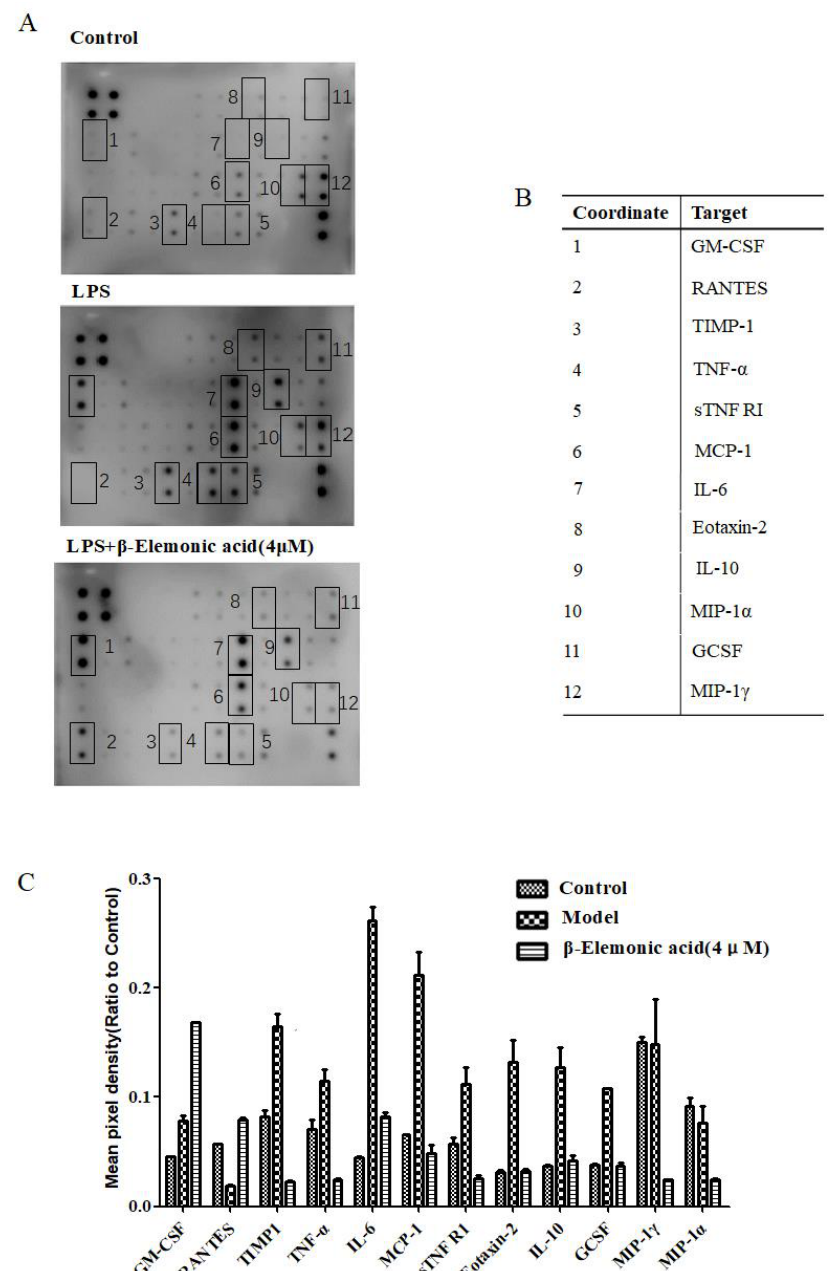
Figure 3. The effect of LPS treatment on the expression of inflammatory cytokines by RAW264.7 cells using antibody array membrane. ( A ) RAW264.7 cells were cultured in DMEM and divided into three treatment groups: control, LPS and LPS+ β -EA (4 µ M). After 24 h of incubation, the cell supernatant were collected and incubated with the antibody array membrane. ( B ) Corresponding to the number in the A picture. ( C ) A visual comparison between the three arrays performed by Quantity One. Data were analyzed by densitometric analysis. Then, background was subtracted and results were normalized against the average of positive